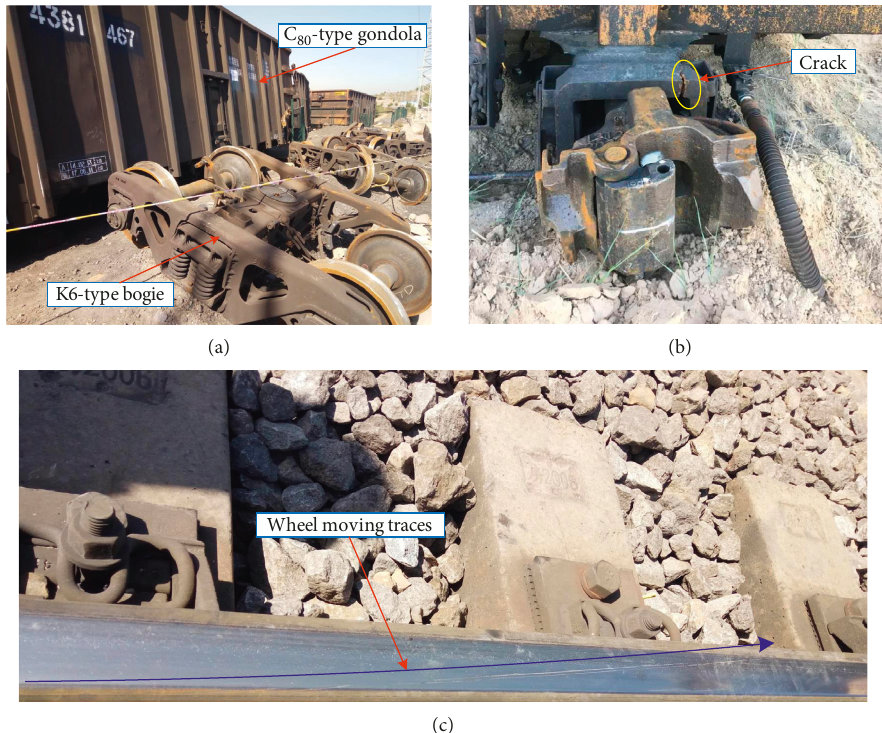
Figure 1: The field investigation: (a) the scene of derailment accident; (b) crack on coupler yoke; (c) wheel moving traces.